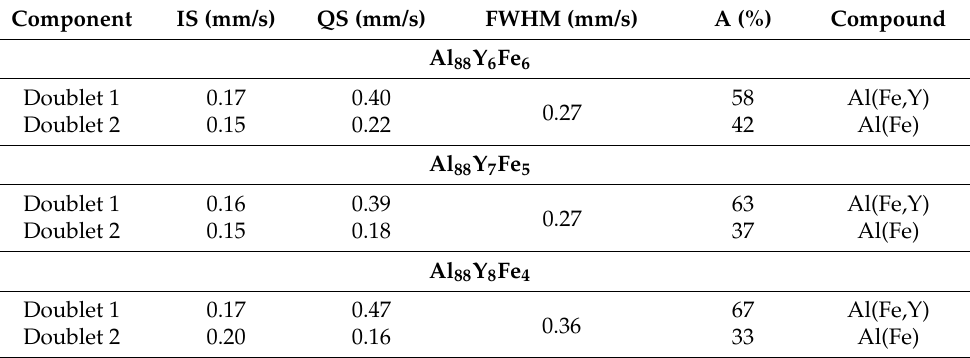
Figure 6. Mössbauer spectra of Al 88 Y 8 Fe 4 , Al 88 Y 7 Fe 5 , and Al 88 Y 6 Fe 6 alloys in the form of ribbons. Table 2. Hyperfine parameters of Al 88 Y 8 − x Fe 4+x (x = 0, 1, 2 at.%) alloys in ribbon states (IS = isomer shift, QS = quadrupole splitting, FWHM = full width at half maximum, A = relative area derived from the spectra).